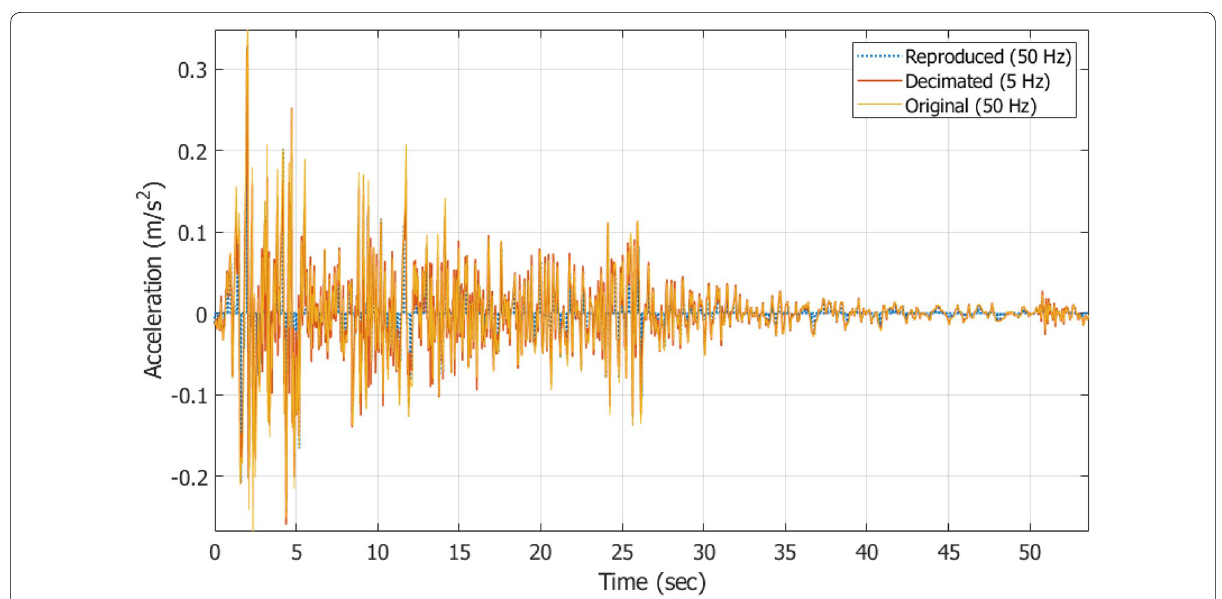
Fig. 12 Comparison of original and reproduced El Centro earthquake ground motion.